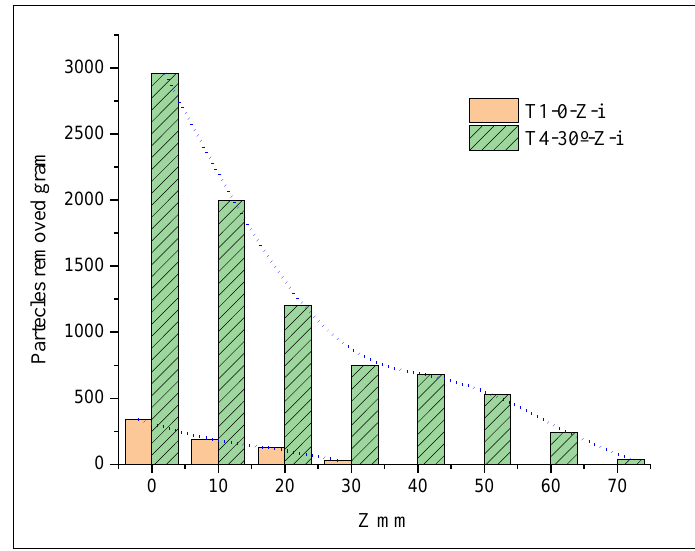
Figure 12. Effect of inlet height on weight of removed sediments.